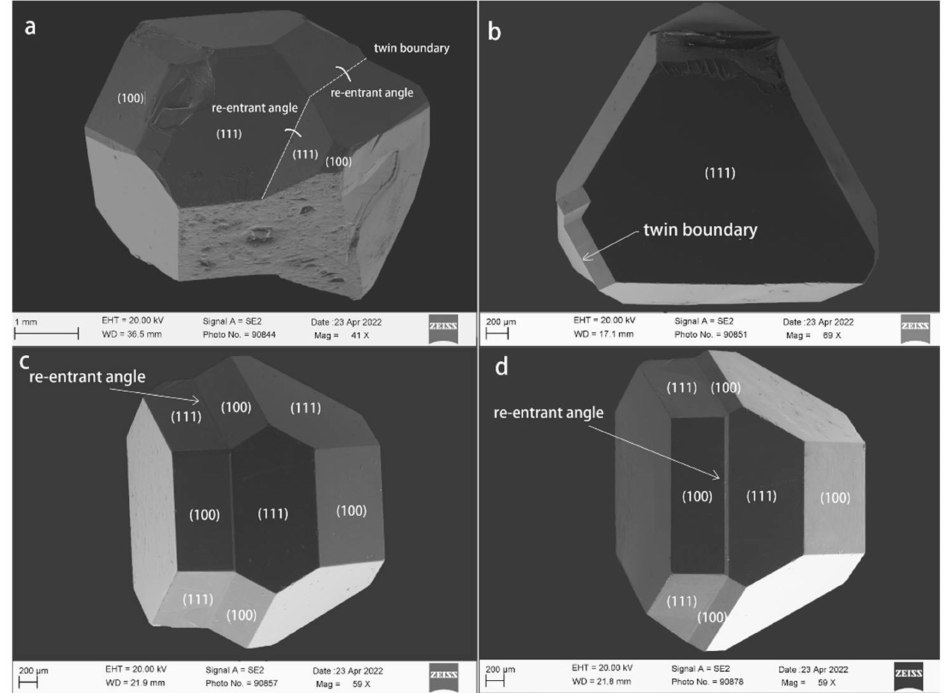
Figure 3. The macroscopic morphology of HPHT synthetically grown diamond crystals with contact twinning observed by SEM: ( a ) the features of the symmetrical crystal morphology and re-entrant angle in TW-01; ( b ) the sample of TW-04 has features of crystal morphology similar to octahedral Macle in natural diamonds; ( c , d ) the single crystal of twining makes contacts with the planes of (100) and (111) in TW-07,